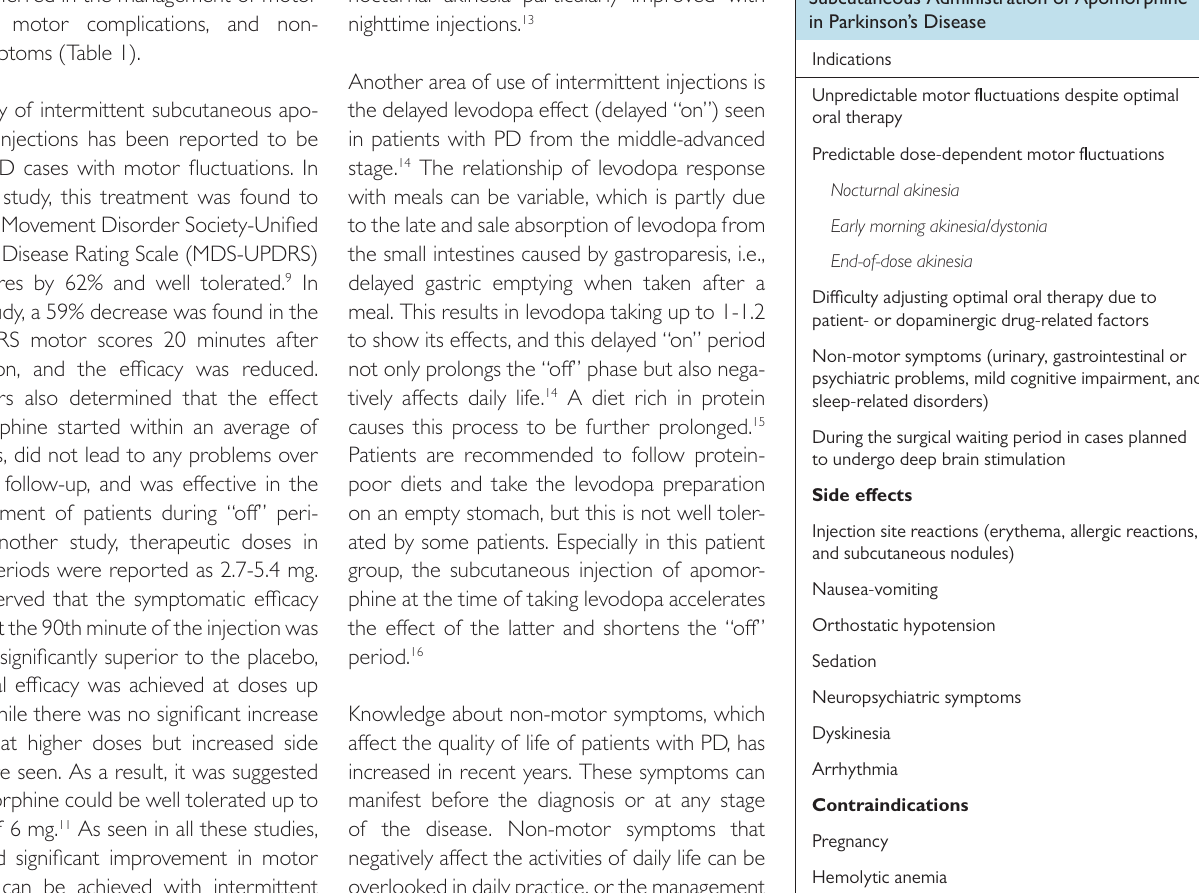
Table 1. Indications, Side Effects, and Contraindications of the Intermittent Subcutaneous Administration of Apomorphine in Parkinson’s